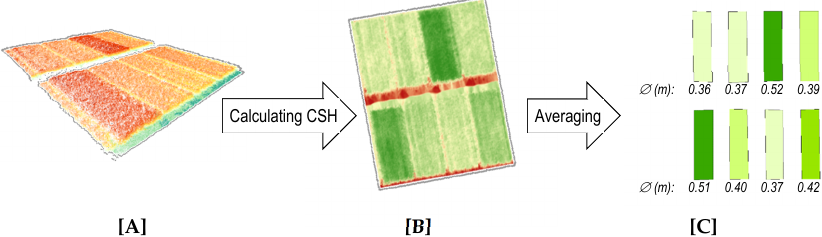
Figure 1. Steps from point cloud to plot-wise averaged crop surface height (CSH): [ A ] Filtered point cloud representing the crop surface; [ B ] Raster data set of CSH; [ C ] Plot-wise averaged CSH values.